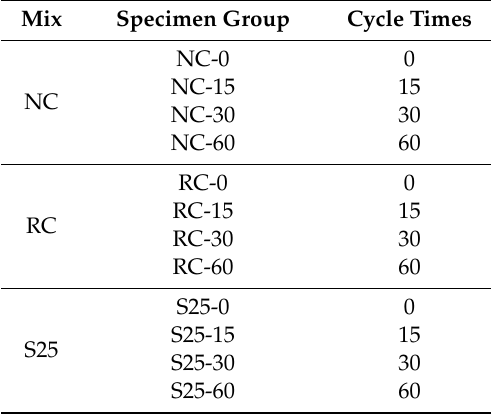
Table 8. Specimen group and test